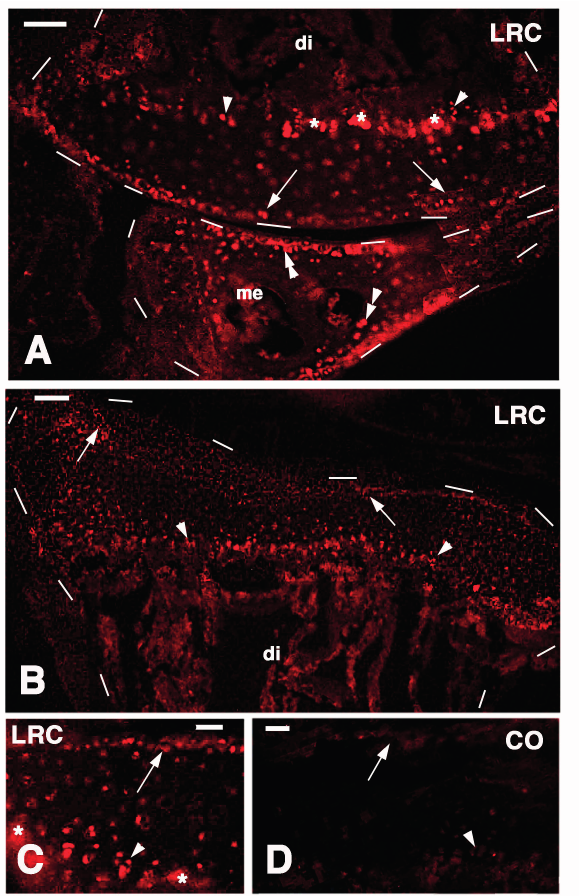
Figure 4. TRITC immunofluorescence for Long Retaining Cells (LRC) in normal articular surfaces of knees. ( A ) sparsely labeled cells (arrows) are seen on the surface of the femur (outlined by dashes; di, diaphysis), metaphyseal growth plate (arrowheads, asterisks indicate non-specific labeling of the mineralized matrix), and meniscus (me, double arrowheads). 50 µm; ( B ) distribution of labeled cells (arrows) in the articular surface (outlined by dashes) and metaphyseal growth plate (arrowheads). di, diaphysis. Bar, 50 µm; ( C ) detail on labeled cells of the superficial region of the articular cartilage (arrow) and serial cartilage (arrowhead) of the metaphyseal growth plate. Asterisks indicate non-specific labeling of the mineralized matrix. Bar, 25 µm; ( D ) control section with indicated the position of the articular cartilage surface (arrow) and metaphyseal growth plate (arrowhead). Bar, 25